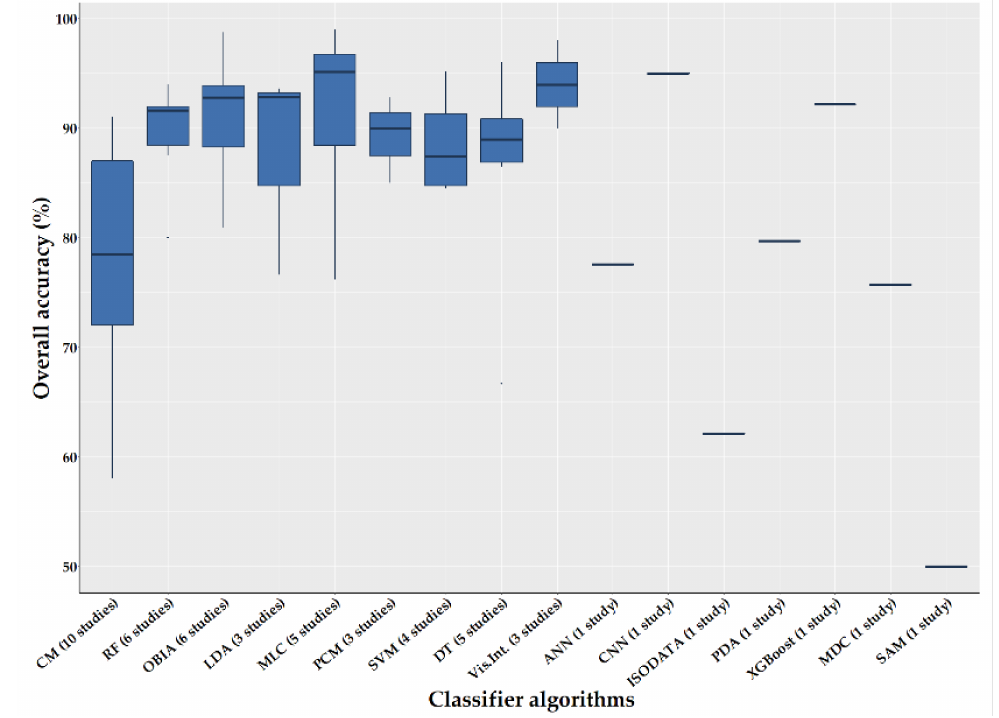
Figure 15. Overall accuracy (OA) (%) achieved with different classification methods (abbreviations were referred in Table